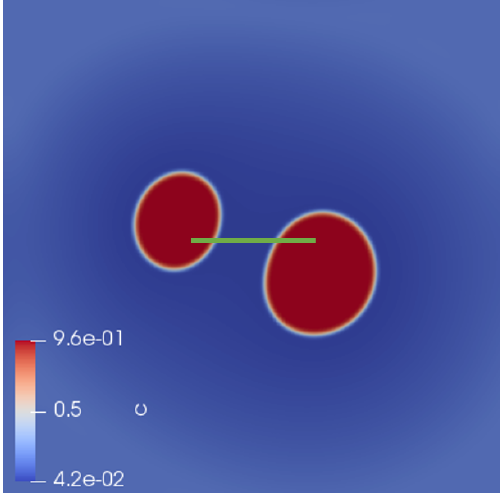
Figure 4. The α ’ phase is nucleated in the Fe-16.4Cr system in the presence of the dislocation. The system size was 256 × 256 µ m 2 . The green horizontal line in the middle represents the line connecting dislocations. The microstructures were visualized by Cr